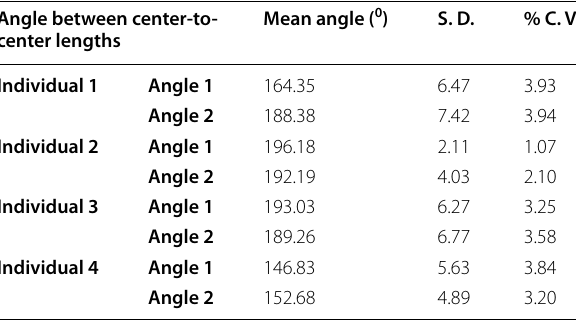
Table 7 Mean pore center-to-center distance, standard